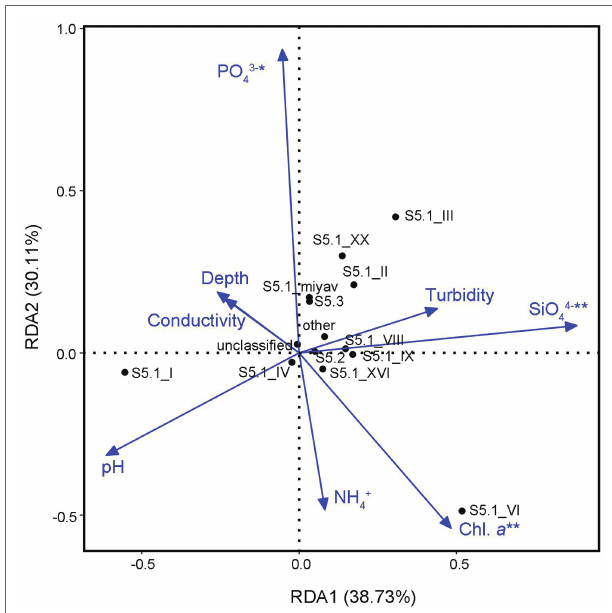
FIGURE 5 | Redundancy analysis (RDA) with the permutation test between Synechococcus clades and environmental